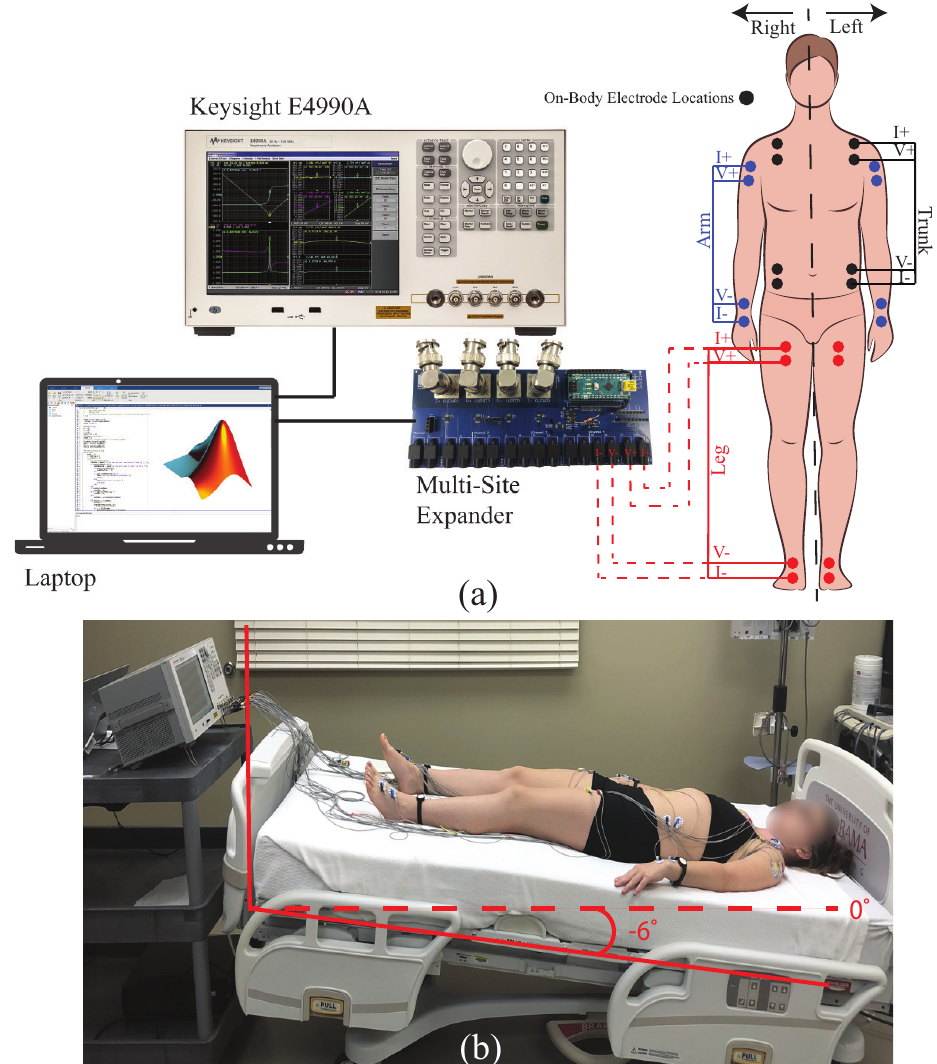
Figure 1. ( a ) Experimental configuration to collect 6 segmental resistance (right/leg arms, trunk, and legs) using Keysight E4990A with multi-site interface expander and ( b ) sample setup of participant during 6 ◦